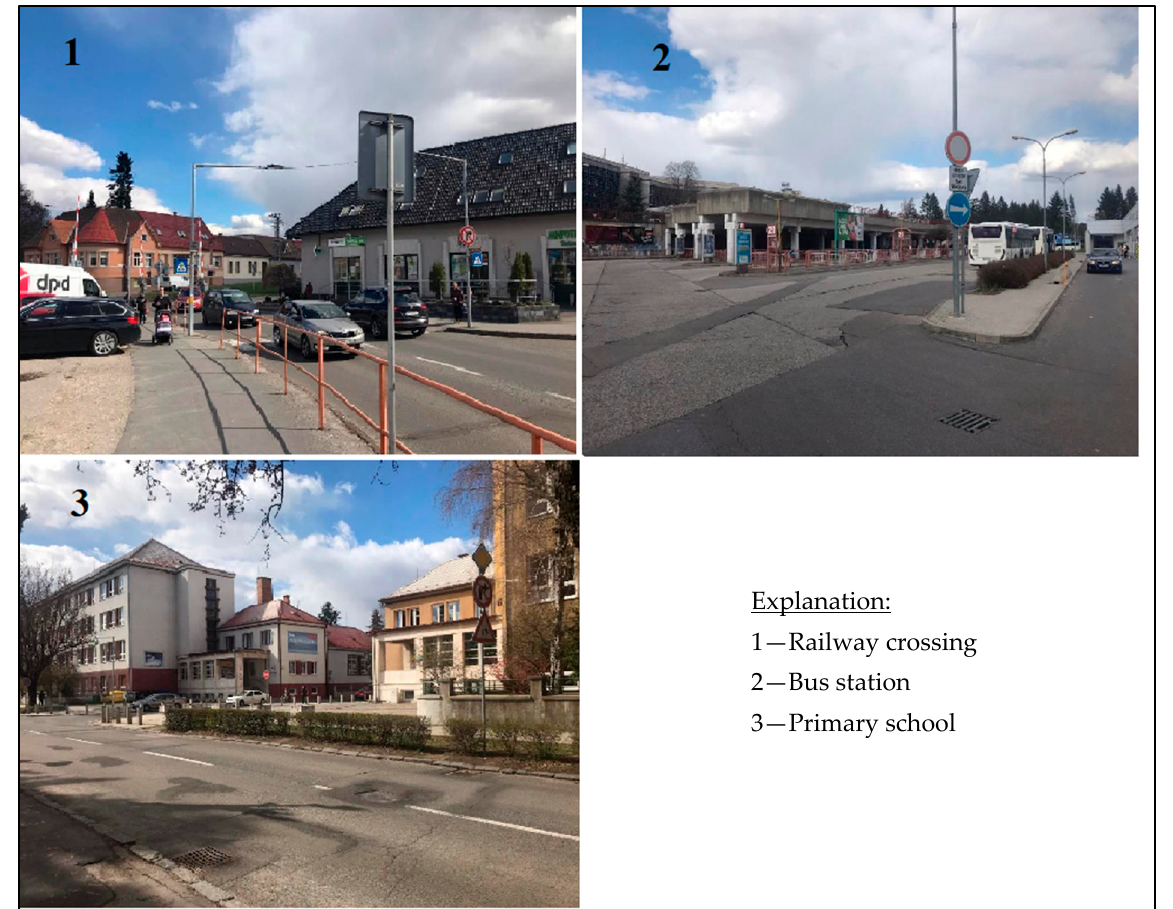
Figure 2. Photographic representation of measurement points.